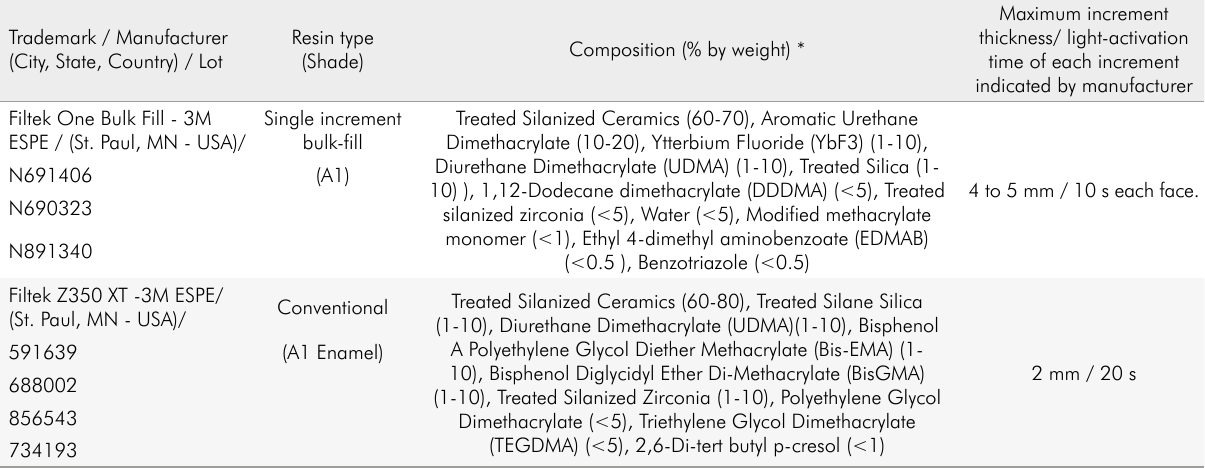
Composition (% by weight)